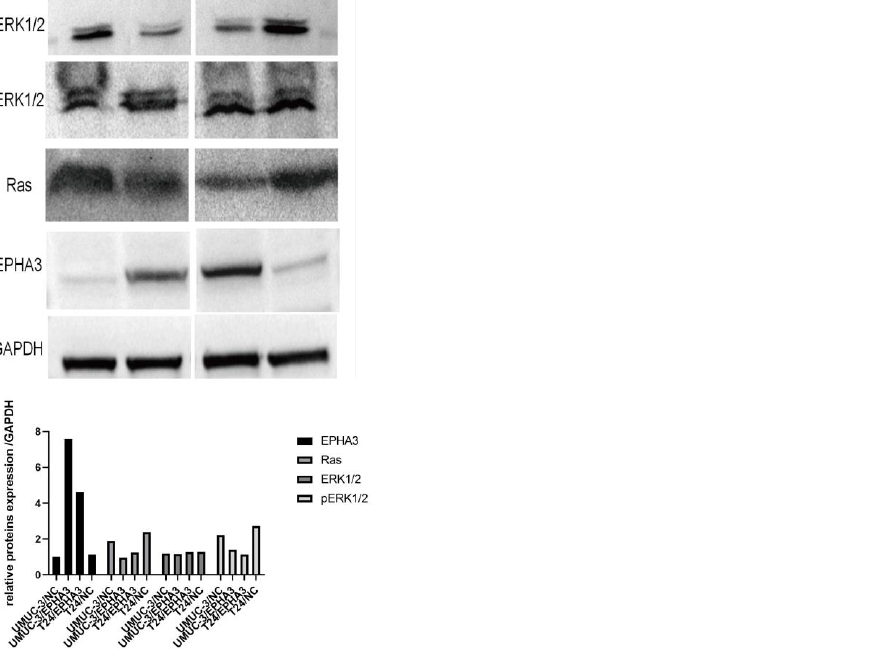
Figure 12. Different protein expressions within T24/NC, T24/EPHA3, UMUC-3/NC, and